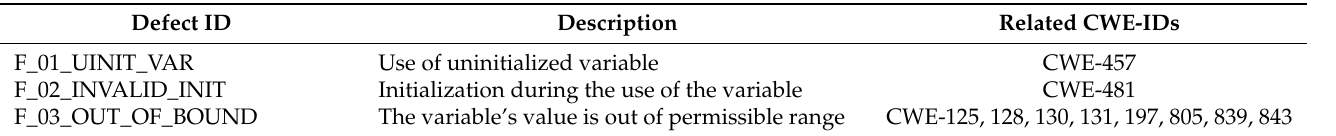
Table 1. Target defects related to incorrect use of variables to be detected.